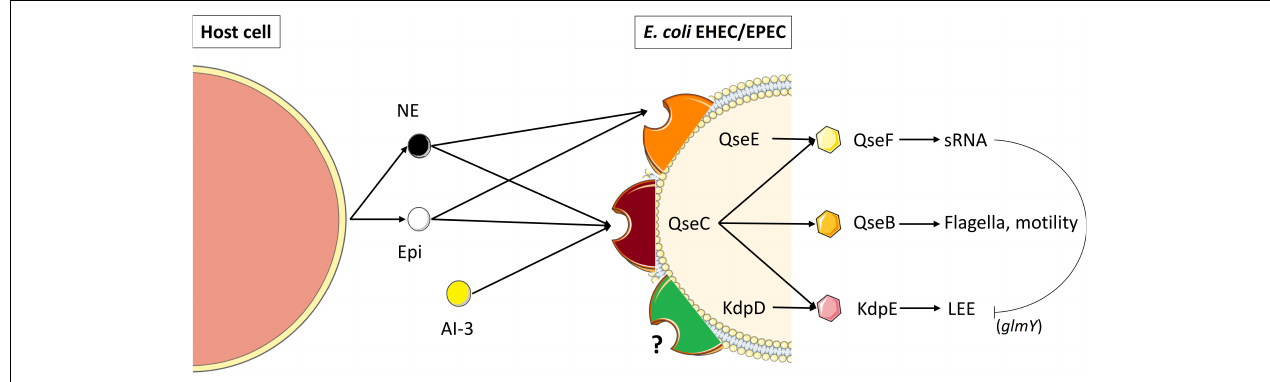
FIGURE 3 | Catecholamine sensing and signal transduction in enterohemorrhagic and enteropathogenic E. coli (EHEC/EPEC). QseC is an adrenergic sensor kinase that autophosphorylates on detection of NE, Epi and AI-3 and transfers the phosphate moiety to its cognate response regulator QseB, thereby activating transcription of the flagellar regulon (Clarke et al., 2006). Transcription of genes encoding a second two-component system (QseEF) is sensitive to NE and Epi and is implicated in small RNAs expression (Reading et al., 2009). Kinase activity in QseC is promiscuous and can activate two additional non-cognate response regulators, KdpE and QseF. QseC also activates the locus of enterocyte effacement (LEE), through KdpE, which is inhibited through sRNAs ( glmY ) that are modulated by QseF. (Adapted from Ellermann and Sperandio, 2020). KdpD, a transmembrane protein showing partial homology with QseC may also act as a catecholamine receptor (Borrel et al.,